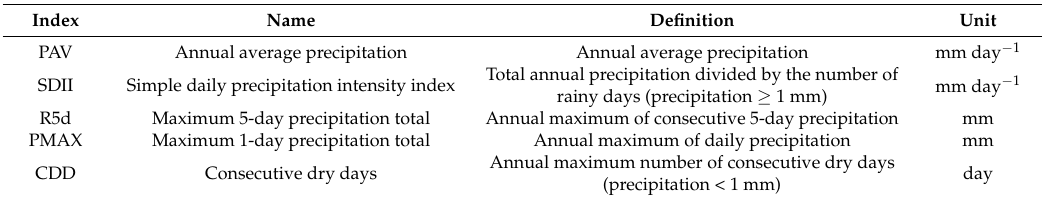
Table 3. Indices of